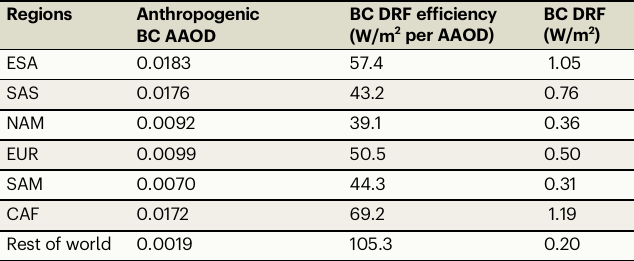
Table 1 | Summary of regional anthropogenic black carbon (BC) aerosol absorption optical depth (AAOD) at 550 nm, BC direct radiative forcing (DRF), and BC DRF ef fi ciency based on our simulation